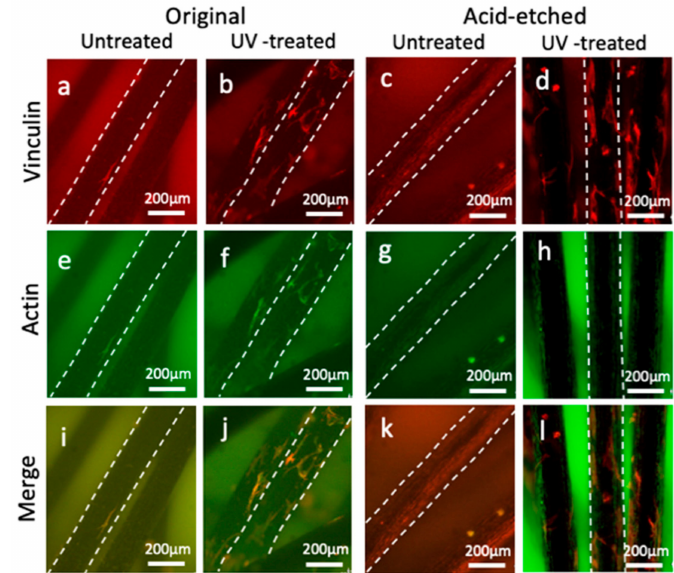
Figure 4. Vinculin and actin staining of osteoblasts on original / acid-etched and untreated / UV-treated Ti microfibers at 3 h: vinculin staining ( a – d ); actin staining ( e – h ); and merged images ( i – l ). Small, round shaped cells sparsely attach on each Ti microfiber. The number of attached osteoblasts on UV-treated microfibers was greater than that on untreated microfibers on both original and acid-etched Ti microfibers. The shape of the osteoblasts on UV-treated acid-etched Ti microfibers ( d , h , l ) spreads and is larger than that on UV-treated original Ti microfibers ( b , f , j ). Dotted white lines show the edges of the fibers.